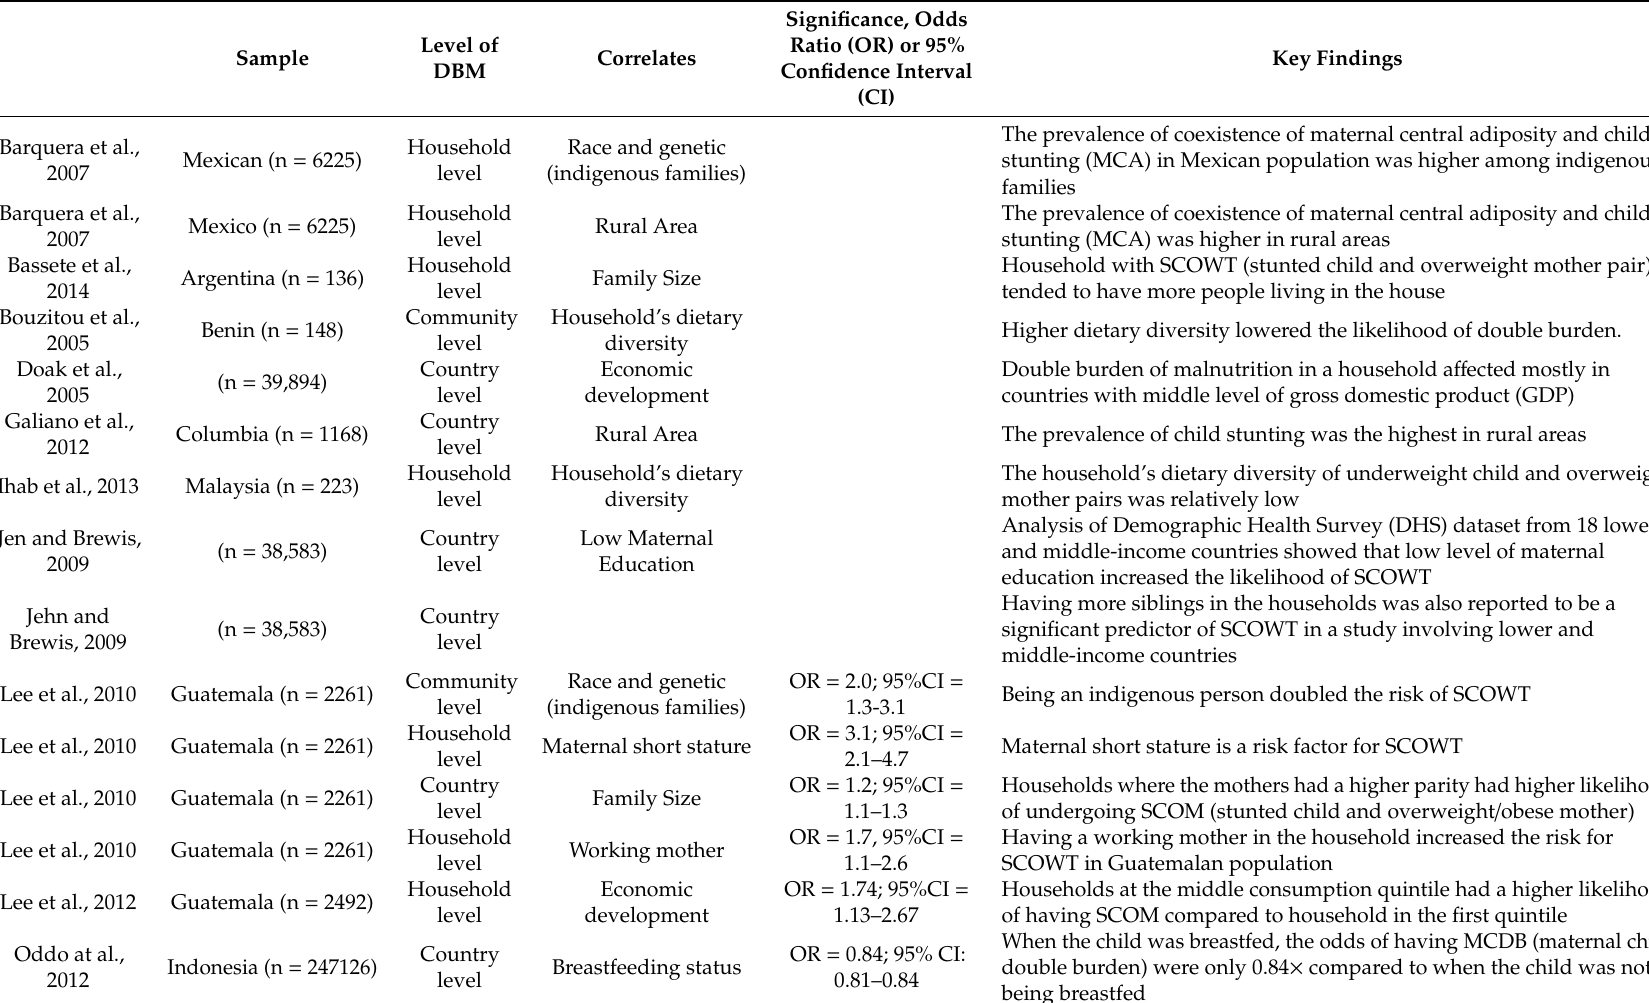
Table A1. Correlates of double burden of malnutrition in developing